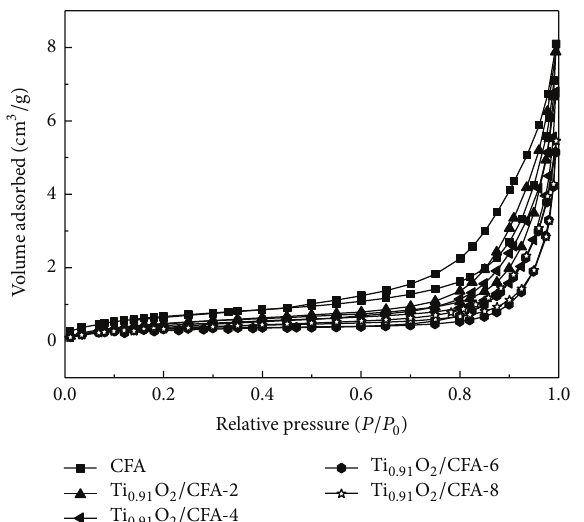
Figure 5: Nitrogen adsorption-desorption isotherms of CFA and Ti 0.91 O 2 /CFA.